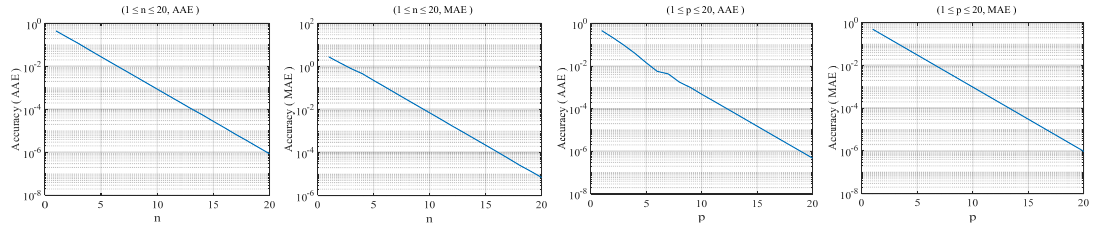
Figure 2. RHC & VLC: Accuracy distribution corresponding to different n or p .